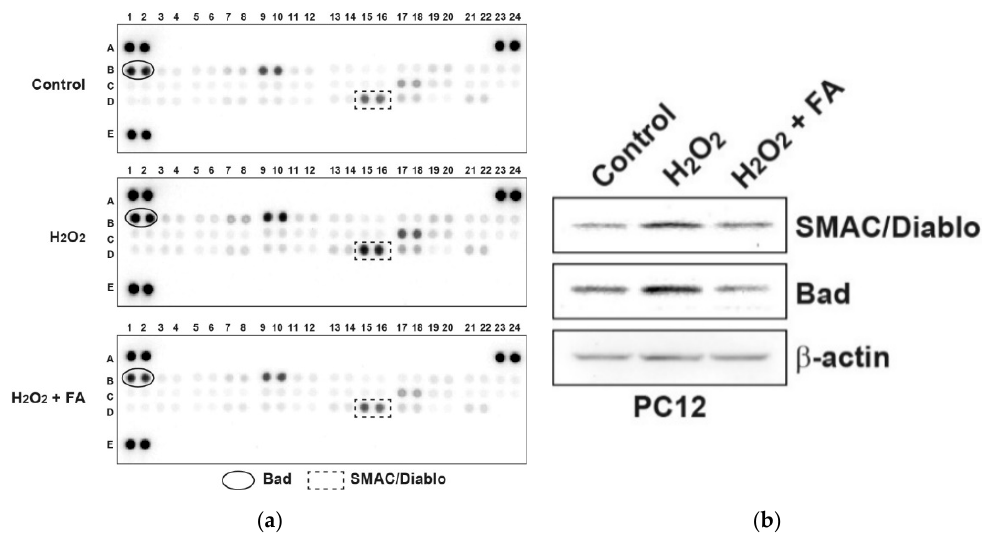
Figure 2. FA inhibits H 2 O 2 -induced apoptosis-related proteins in PC12 cells. ( a ) PC12 cells were pretreated with FA (40 µM) overnight and subsequently cultured cells in the absence or presence of H 2 O 2 (0.5 mM) for another 30 min. Cell lysates were evaluated by apoptosis-related proteins antibody array according to the manufacturer’s instructions. The intensity of each dot/phosphoprotein was measured using Image J software. ( b ) Results of the array were validated by Western blot analysis.